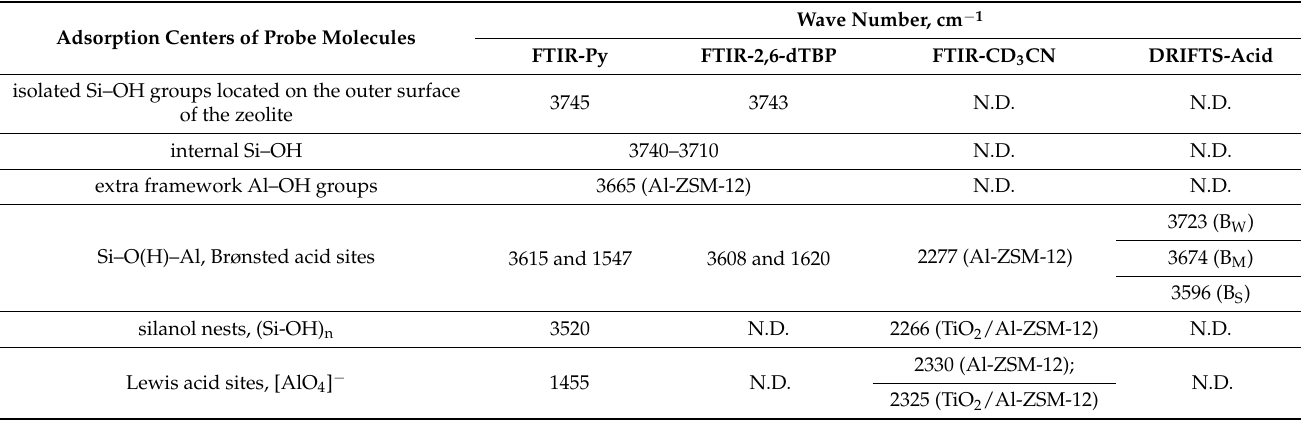
Table 3. Bands identifying the main structural groups of zeolites and Brønsted and Lewis acid